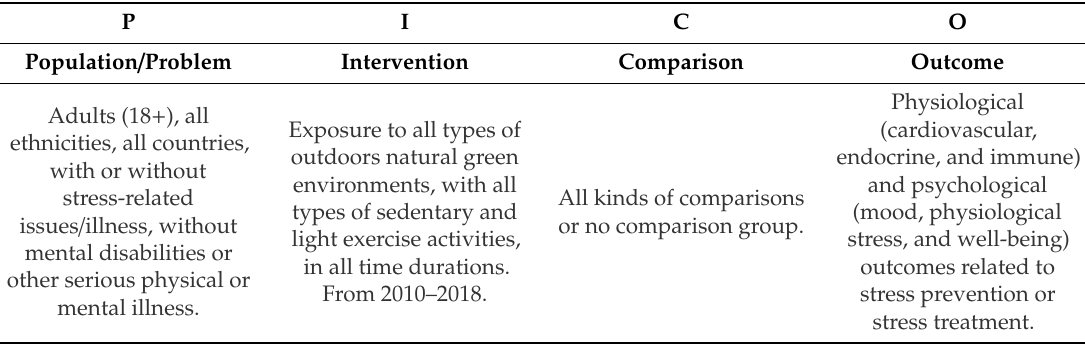
Table 1. Population, intervention, comparison, and outcome